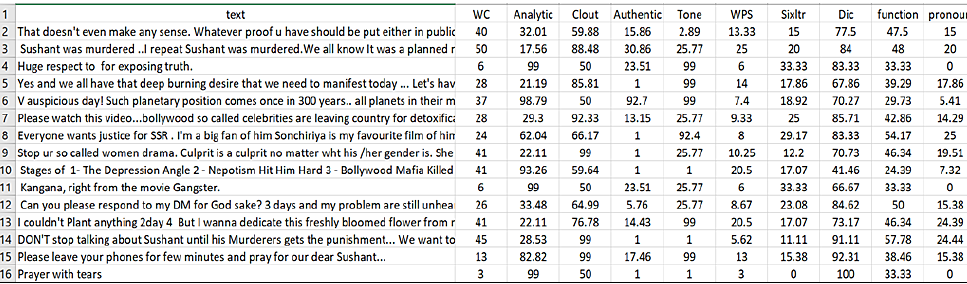
Figure 6. Snapshot of LIWC